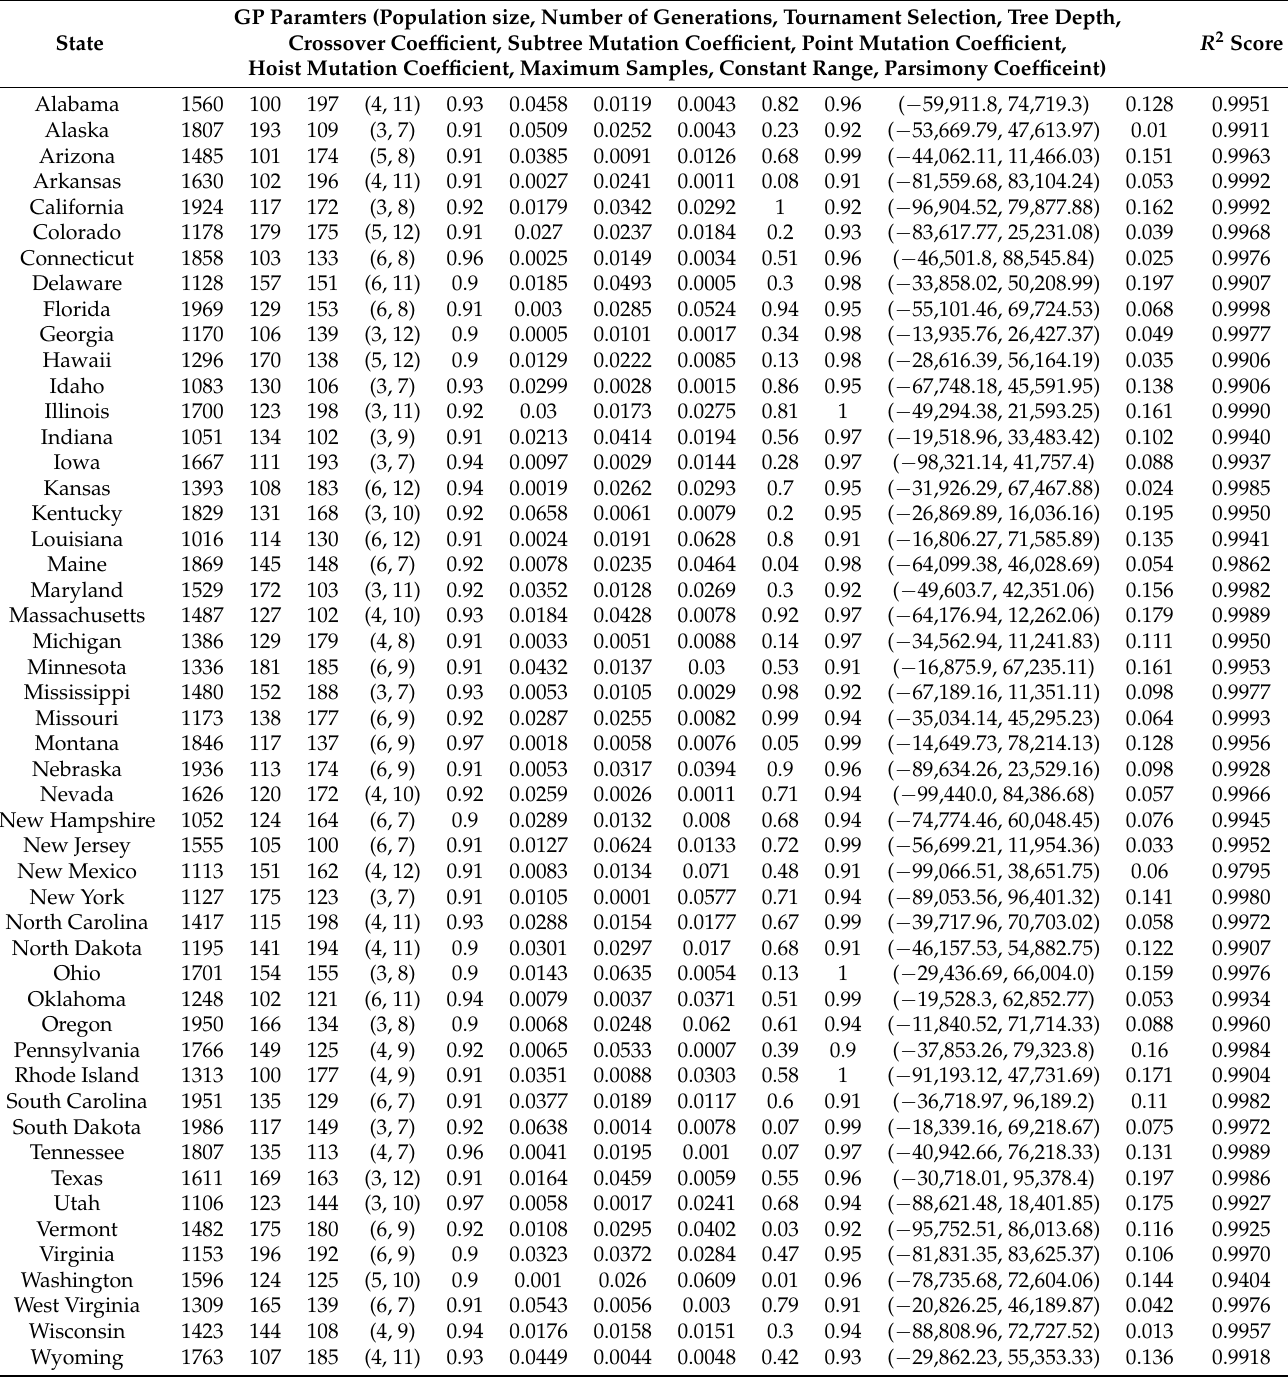
Table A2. GP parameters used to obtain symbolic expressions of deceased patients for each state with achieved R 2